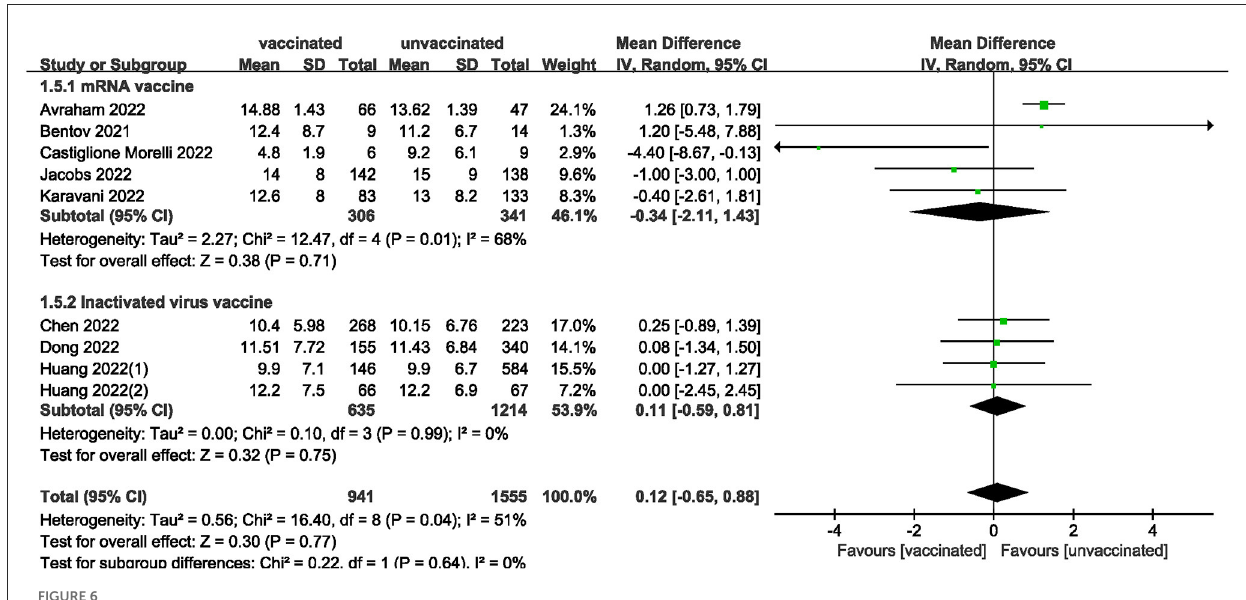
FIGURE6 Forest plot of number of oocytes for vaccinated vs.